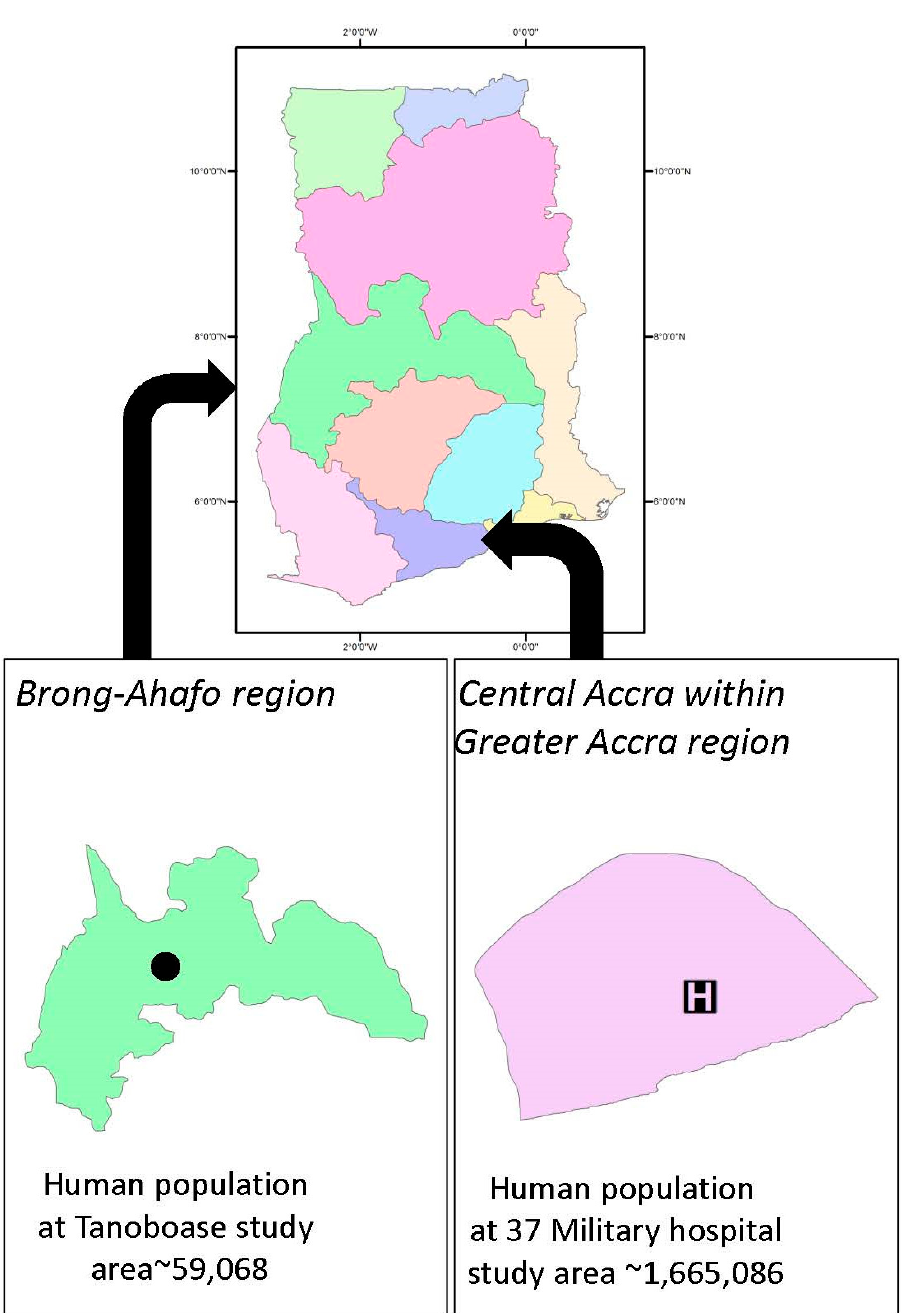
Figure 1. Locations at which wild straw-colored fruit bats ( Eidolon helvum ) were captured and